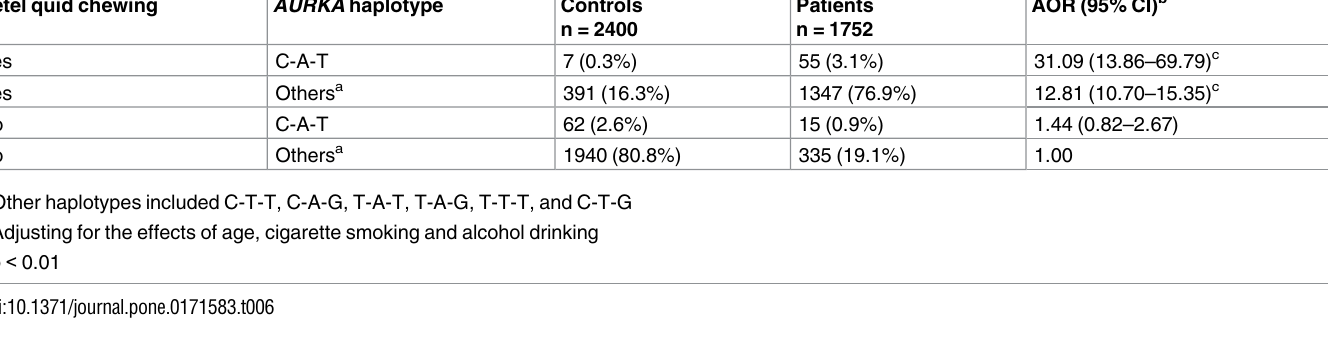
Table 6. Combined effect of betel quid chewing and AURKA haplotypes on OSCC development. Betel quid